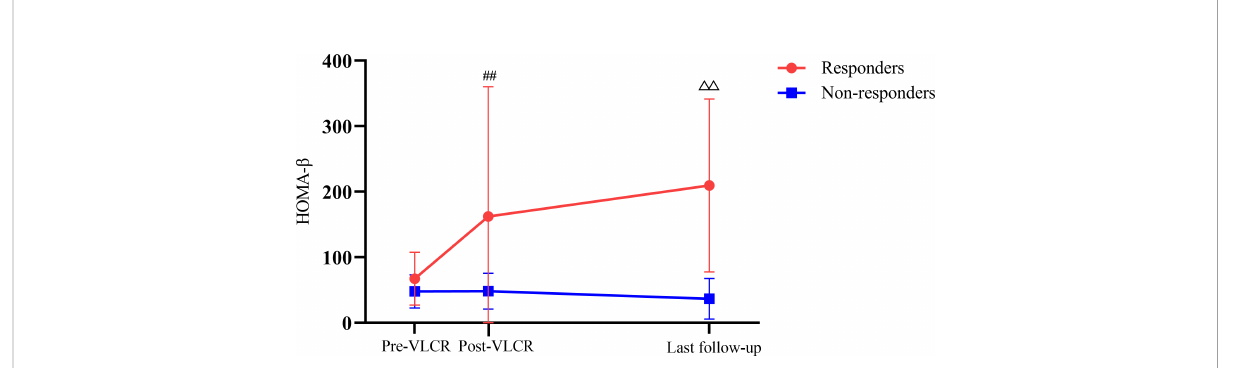
FIGURE 5 HOMA- b before and after VLCR, as well as at the last follow-up in responders and non-responders. ## P <0.01, responders vs. non-responders post-VLCR; △△ P <0.01, responders vs. non-responders at the last